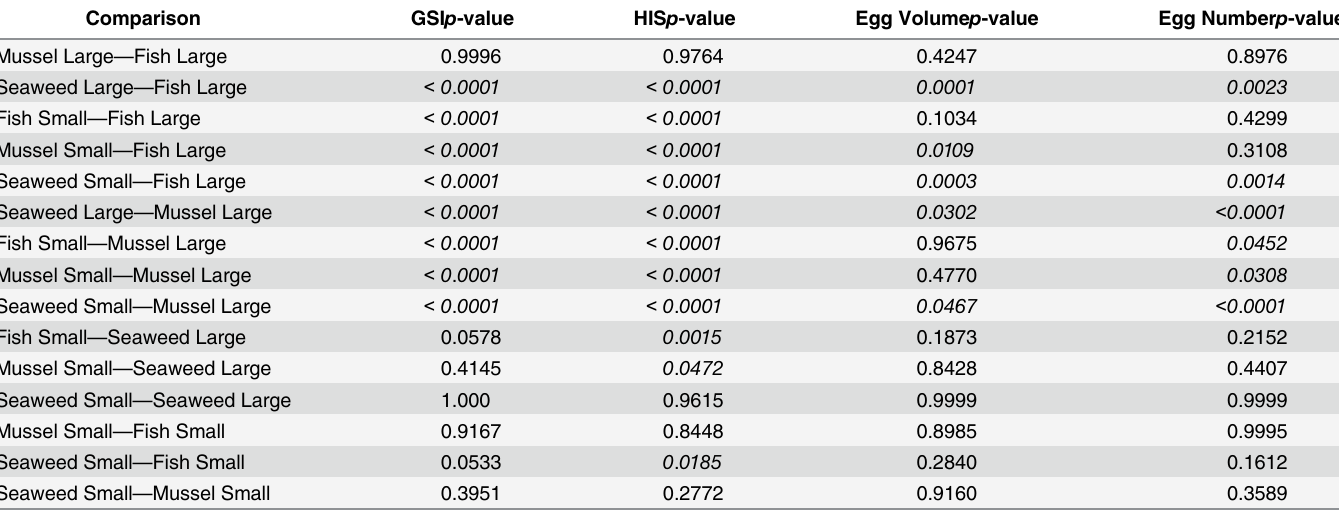
Table 1. Analysis of Tukey ’ s HSD multiple comparison test to determine pairwise differences in the gonadosomatic index (GSI), hepatosomatic index (HSI), egg volume, and egg number of crabs given different diets.